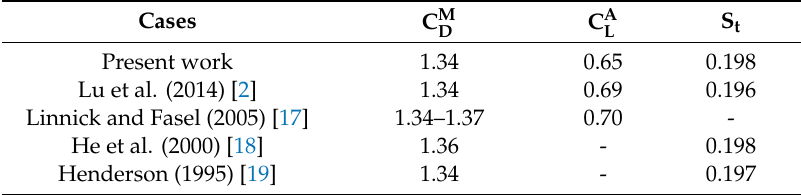
Table 3. Comparison of C M , C A , and S t for a circular cylinder (Re = 200).